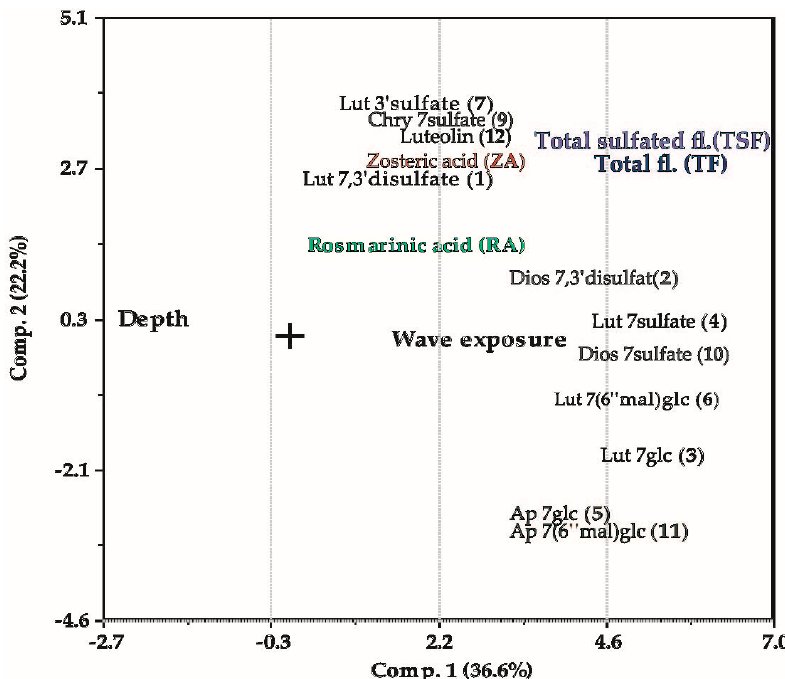
Figure 6. PCA loadings (PC1 vs. PC2), showing the correlations between variables depth, wave exposure, flavonoids ( 1 - 7 , 9 - 12 , TF and TSF) and phenolic acids (RA, ZA) in the current Zostera marina dataset (see Figure 1 for structures).